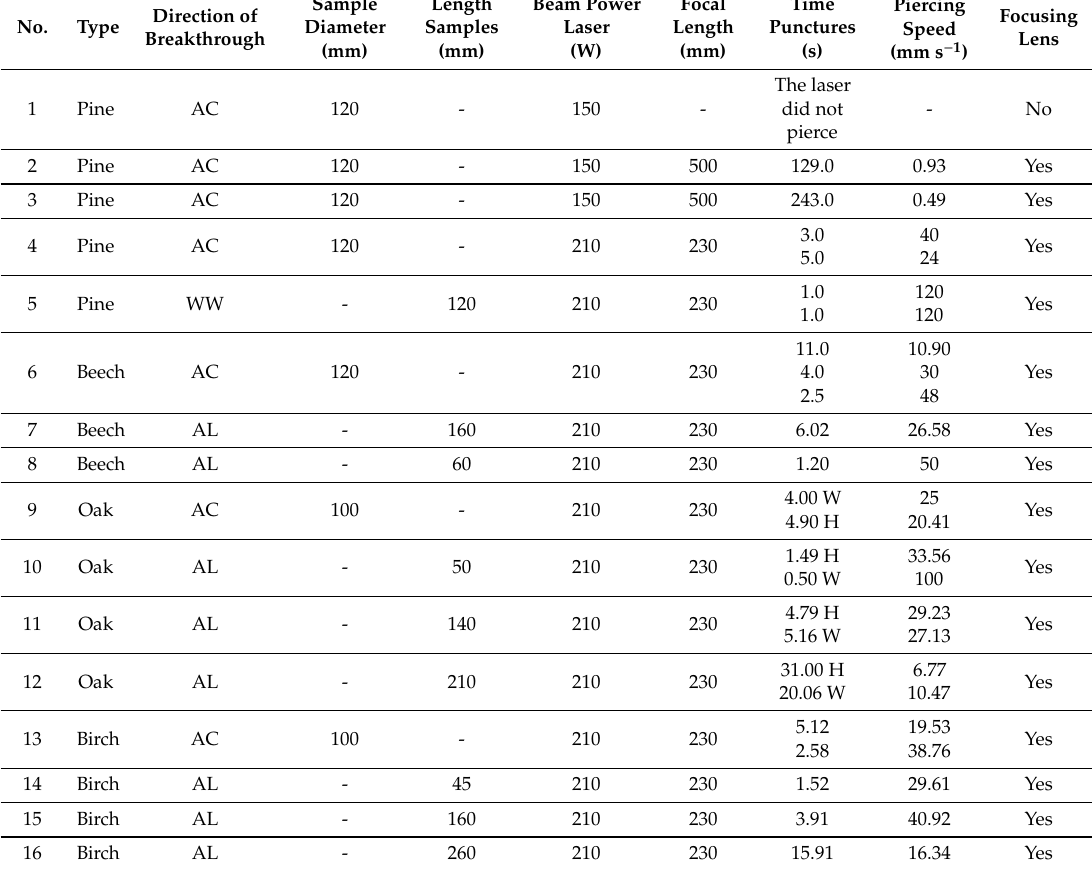
Table 1. The results of the measurements of the impact of the fiber laser beam on